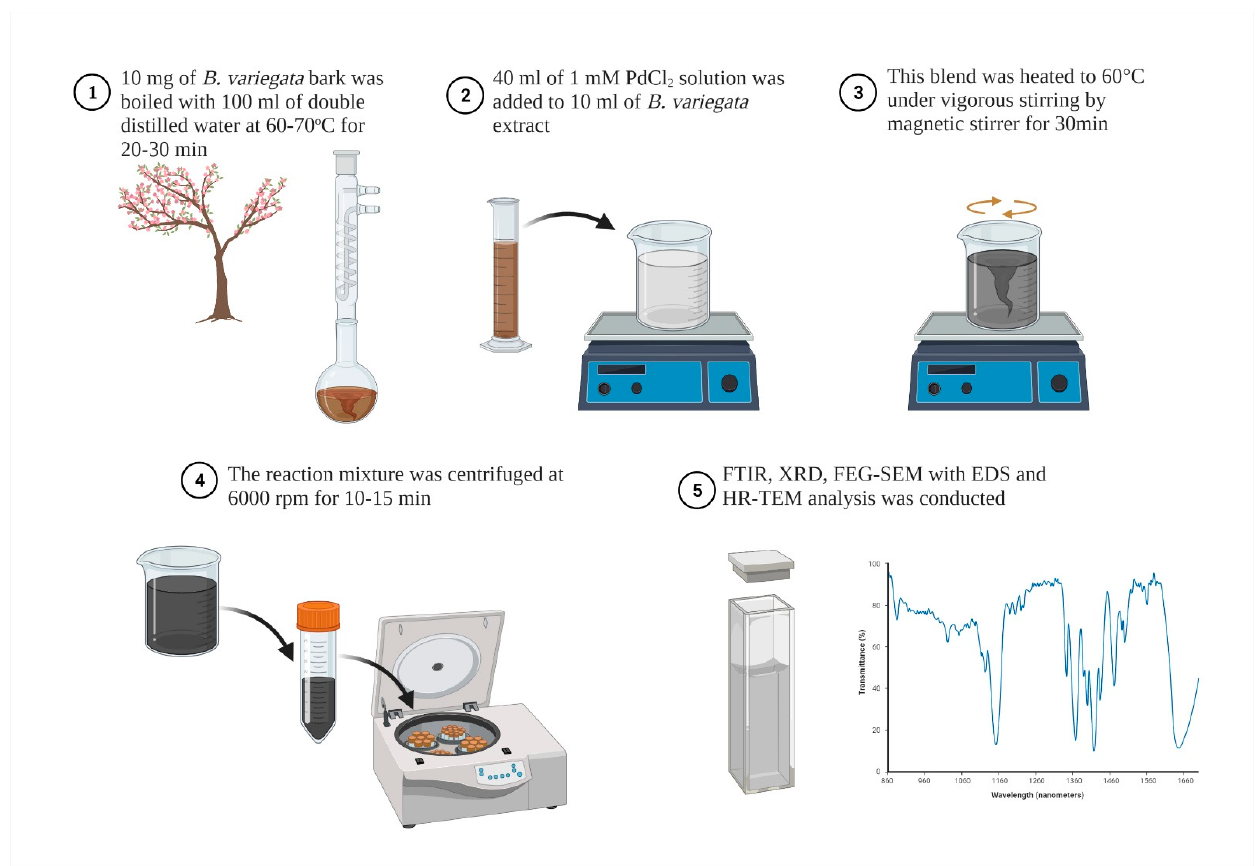
Figure 3. Biosynthesis of Pd NPs via B. variegata extract (Created with BioRender.com accessed on 29 July 2022).